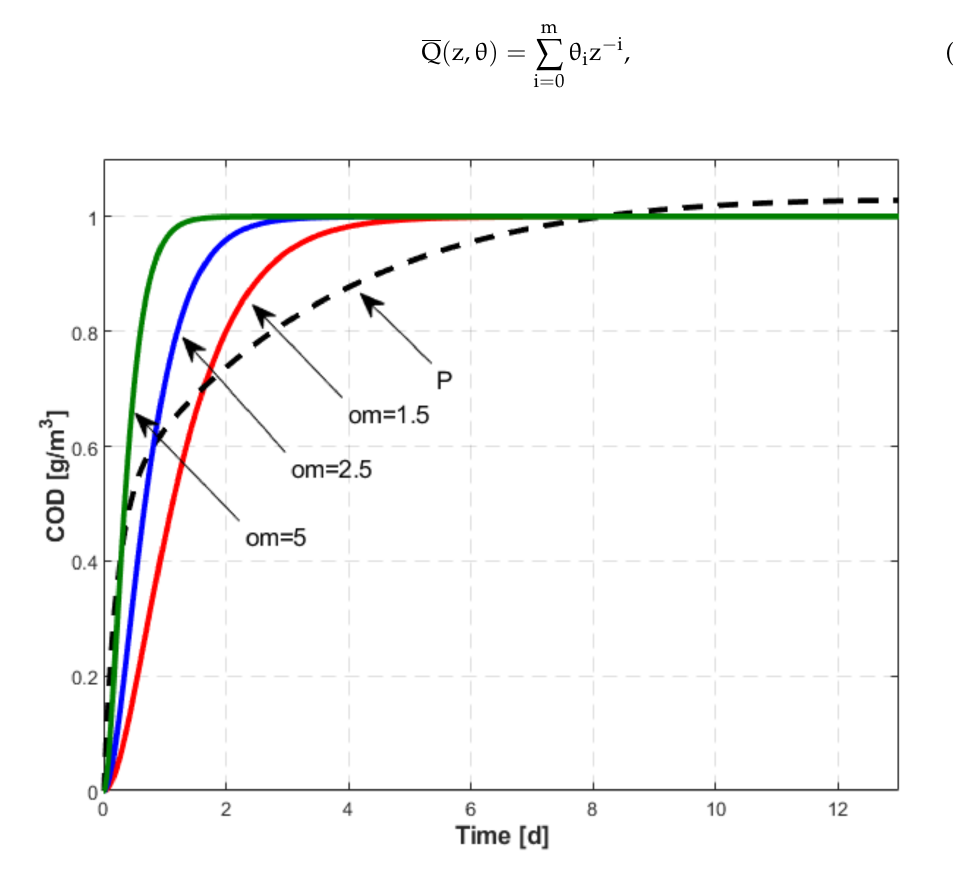
Figure 4. The process response for a step of amplitude 0.1 (P) and the unit step responses of reference models with (cid:101) ω =